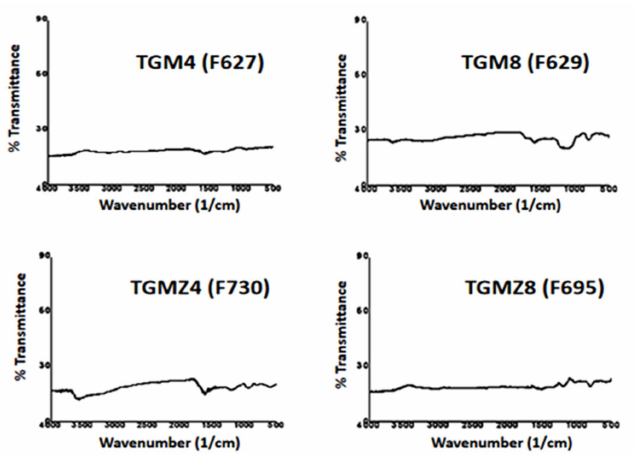
Figure 10. FTIR spectra of CNS (without Z) and ZnO/CNS (with Z) which were prepared at 400 W (code 4) and 800 W (code 8) from biomass of rice husk (G).